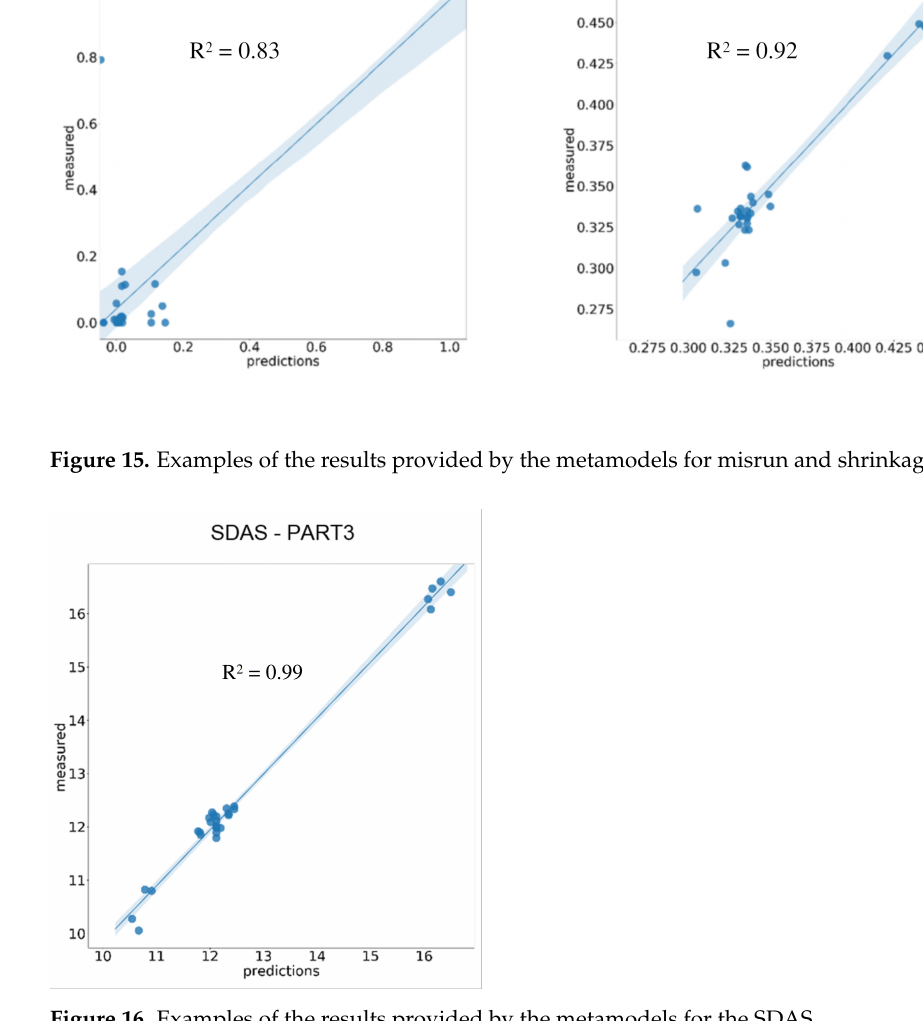
Figure 16. Examples of the results provided by the metamodels for the